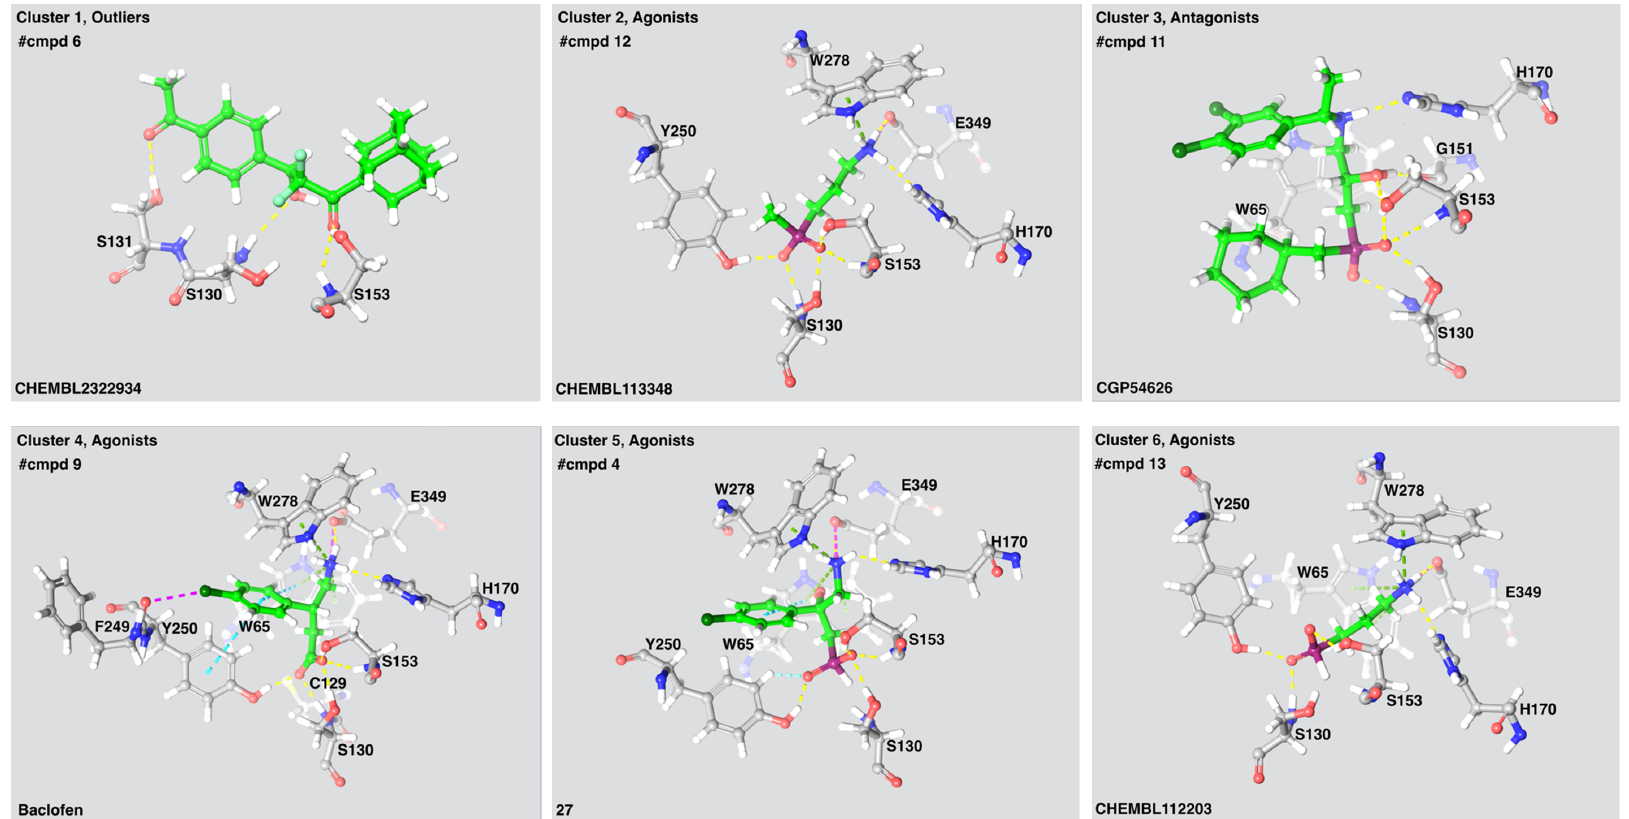
Figure 3. The ligand-receptor interactions of a selected compound from each cluster. Compound name is indicated in the lower left corner of each panel. The number of compounds (#cmpds) in each cluster and the intrinsic activity of the compounds is indicated. Cluster 1 consist of two antagonists and four agonists. Yellow lines: hydrogen bonds, green lines: Pi-cation interactions, Cyan lines: salt bridges, light blue lines: aromatic hydrogen bonds, magenta—halogen bond.